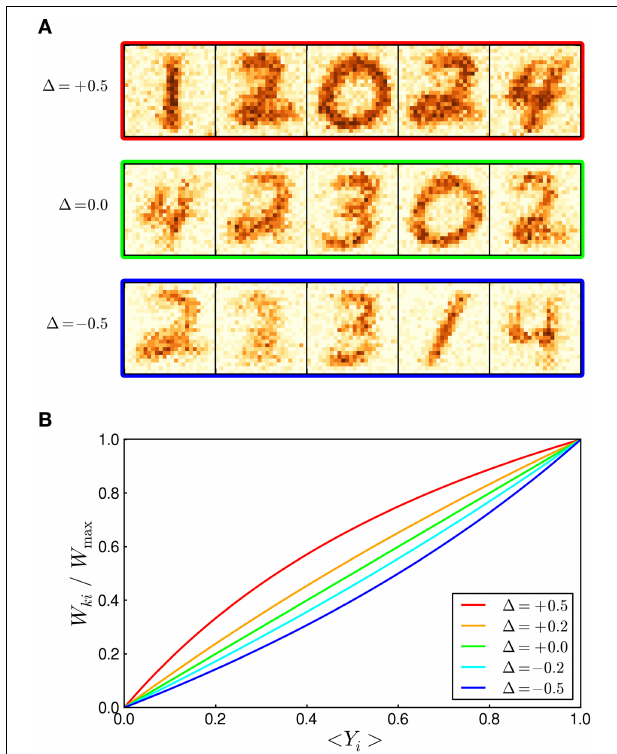
FIGURE 6 | Robustness to unbalanced switching probabilities. (A) Examples of learned weight matrices when the switching probabilities π up and π down are systematically unbalanced. The parameter /π up measures the relative imbalance between LTP and (cid:6) := ( π up − π down ) LTD transitions. The top (bottom) row shows weight matrices resulting from a 50% decrease (increase) of the LTD switching probability. The balanced case is shown in the middle row for comparison. (B) Systematic imbalance ( (cid:6) (cid:7)= 0) leads to changed equilibrium points in the STDP rule and can be theoretically understood as a non-linear encoding of the expected input by the synaptic